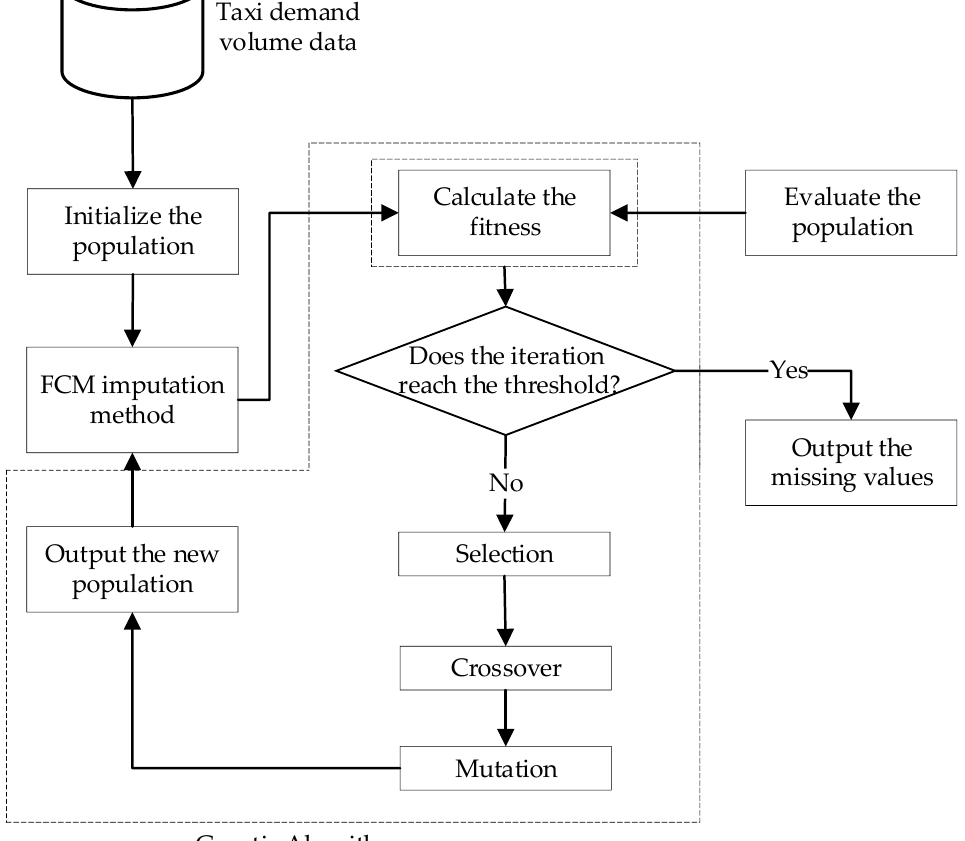
Figure 4. Flowchart of the integrated imputation algorithm.